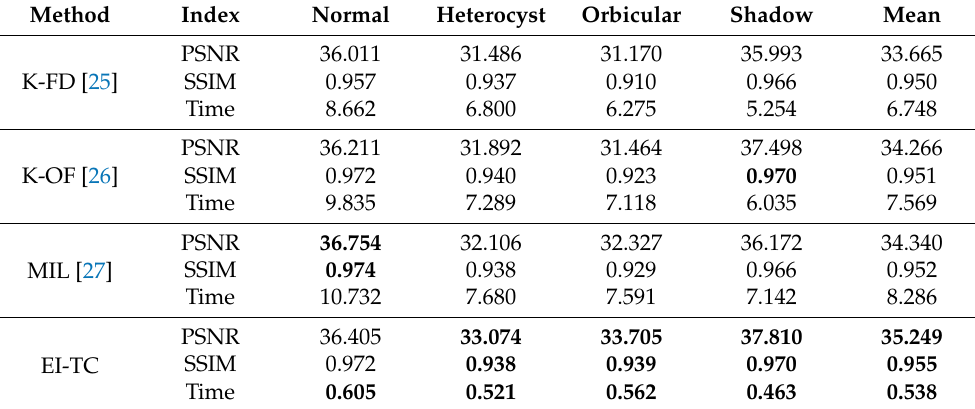
Table 1. Comparison of PSNR, SSIM, and time consumption between four key frame extraction methods in different typical morphologies of urinary red blood cells. The bolded numbers are the best